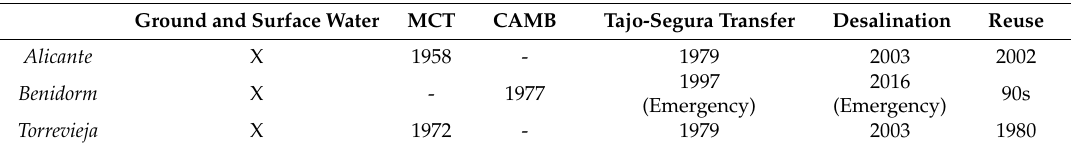
Table 1. Chronological incorporation of supply sources.